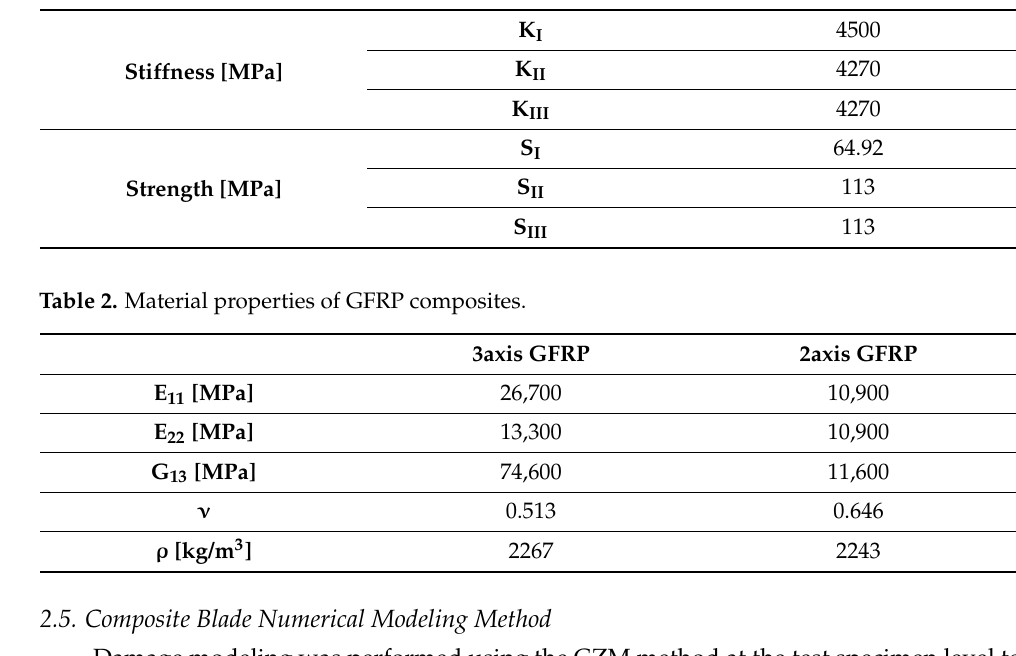
Table 1. Material properties of FM73.